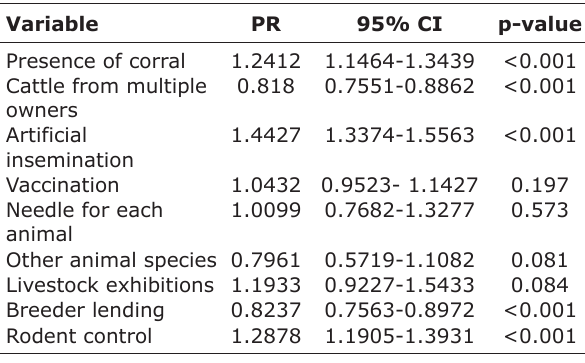
Table-5: Analysis of field and practices as possible risk factors for BLV. Variable